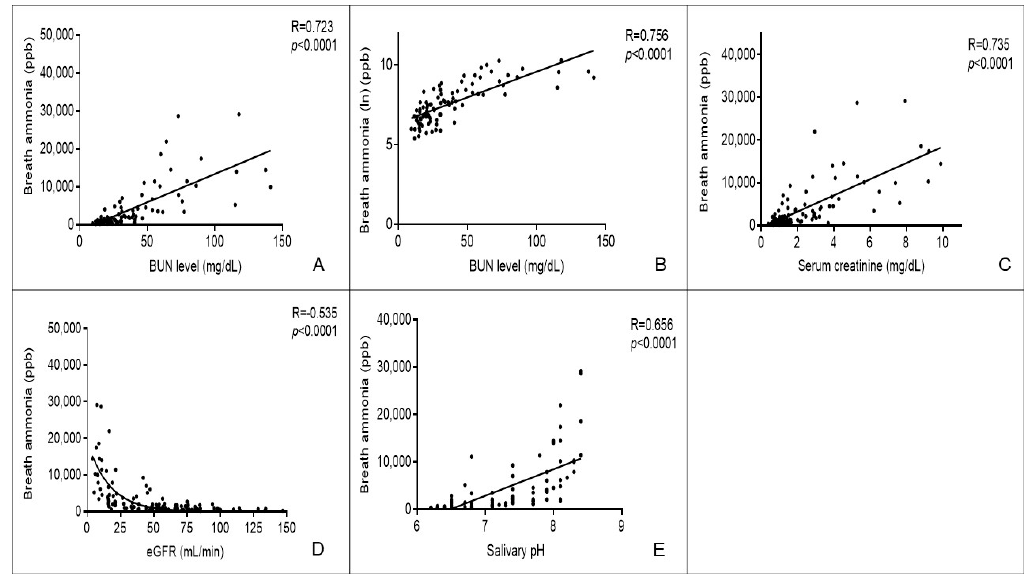
Figure 2. Correlation between breath ammonia and salivary pH value, blood urea nitrogen (BUN), serum creatinine, and estimated glomerular filtration rate. ( A ) Correlation between breath ammonia concentration and BUN level. ( B ) Correlation between breath ammonia concentration (natural logarithm) and BUN level. ( C ) Correlation between breath ammonia concentration and serum creatinine level. ( D ) Correlation between breath ammonia concentration and estimated glomerular filtration rate (eGFR). ( E ) Correlation between breath ammonia concentration and salivary